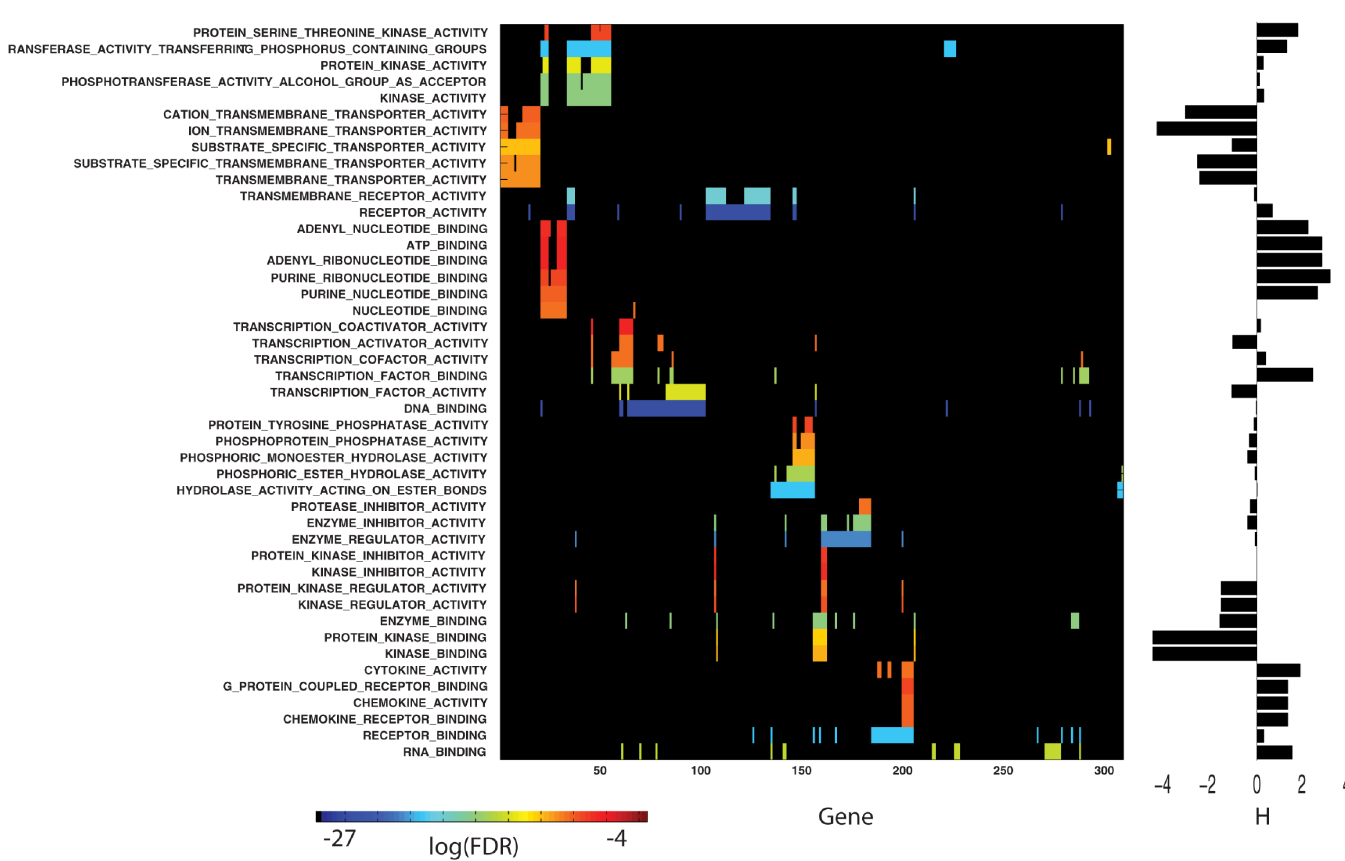
Fig 7. Clustered plot of the topmost significant GSEA pathways and the genes appearing in each pathway. Rows (GSEA Pathways) and columns (one for genesin each pathway, zero otherwise) have been clusteredusing Minkowski distancemetric and Wards linkage. Pathway genesin each row of this clusteredplot are colored spectrallyby their log(FDR p-val), (blue to red, most to least negative)as listed in S4 Table . FDR values were not used for clustering, only the presence or absenceof pathway genes. The top 45 GSEA pathways were arbitrarily selectedfor displayto enhancereadabilityof labels. The completeclustered plot for all significant(FDR < 0.05) GSEA pathways appearsin S2 Fig . The pathway fitness scores, H, appearin the vertical bar plot at the right. A minimum of 5 genesare requiredfor a non-zerofitness score. Table 2 summarizes the pathway-fitness-selected genes for the sorafenib meta-clusters. An illustration of using positive and negative pathway fitness scores for identifying potentially important genes is provided below. An example meta-cluster with positive pathway fitness scores, appearing in meta-cluster (rows 1–5) finds TYK2, SPHK1 , EFNA4 , TRIB1 and NEK11 . The first three genes are relatively under expressed in sorafenib responders versus non-responders while the latter two genes are relatively over expressed in sorafenib responders versus non-responders. The effects of relative under expression for these genes may be inferred from the literature. TYK2 is a member of the Janus kinase family which is involved in activat- ing the JAK-STAT (Signal Transducer and Activator of Transcription) signaling pathway and driving cell proliferation [57]. Resistance to sorafenib has been proposed to involve crosstalk between PI3K/AKT and JAK-STAT pathways[58], with literature support for TYK2 interfer- ence with sorafenib efficacy[59]. Under expression of TYK2 may diminish JAK-STAT’s role in cell proliferation and contribute to enhanced sorafenib efficacy. The pro-apoptotic lipid sphin- gosine, when phosphorylated by sphingosine kinases (SKs), inclusive of SPHK1 (Sphingosine Kinase 1), generates the mitogenic lipid sphingosine-1-phosphate. Inhibition of SKs’ activity delays tumor growth in a mouse mammary adenocarcinoma model, suppresses the MAP